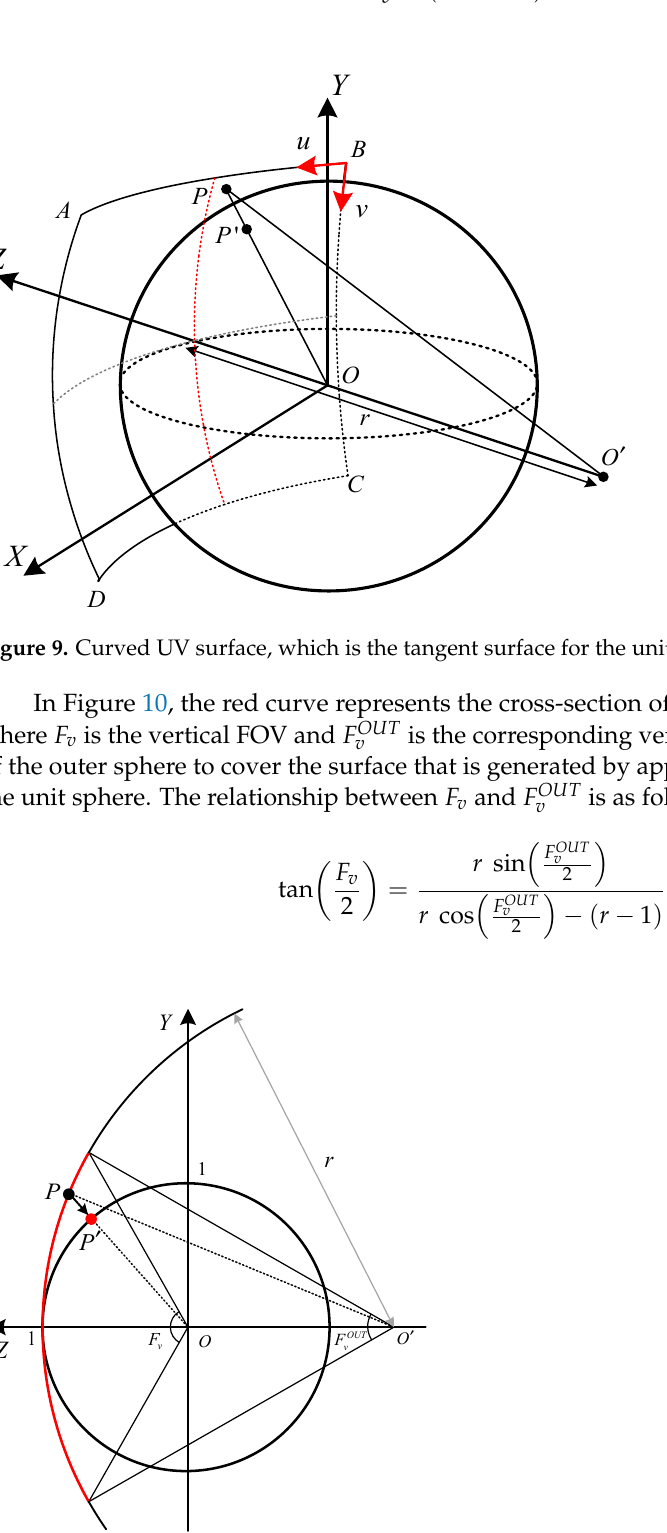
( h ) FOV = 120, r = 0.3 Figure 11. Viewport pictures (VPs) resulting from applying the curved UV surface.